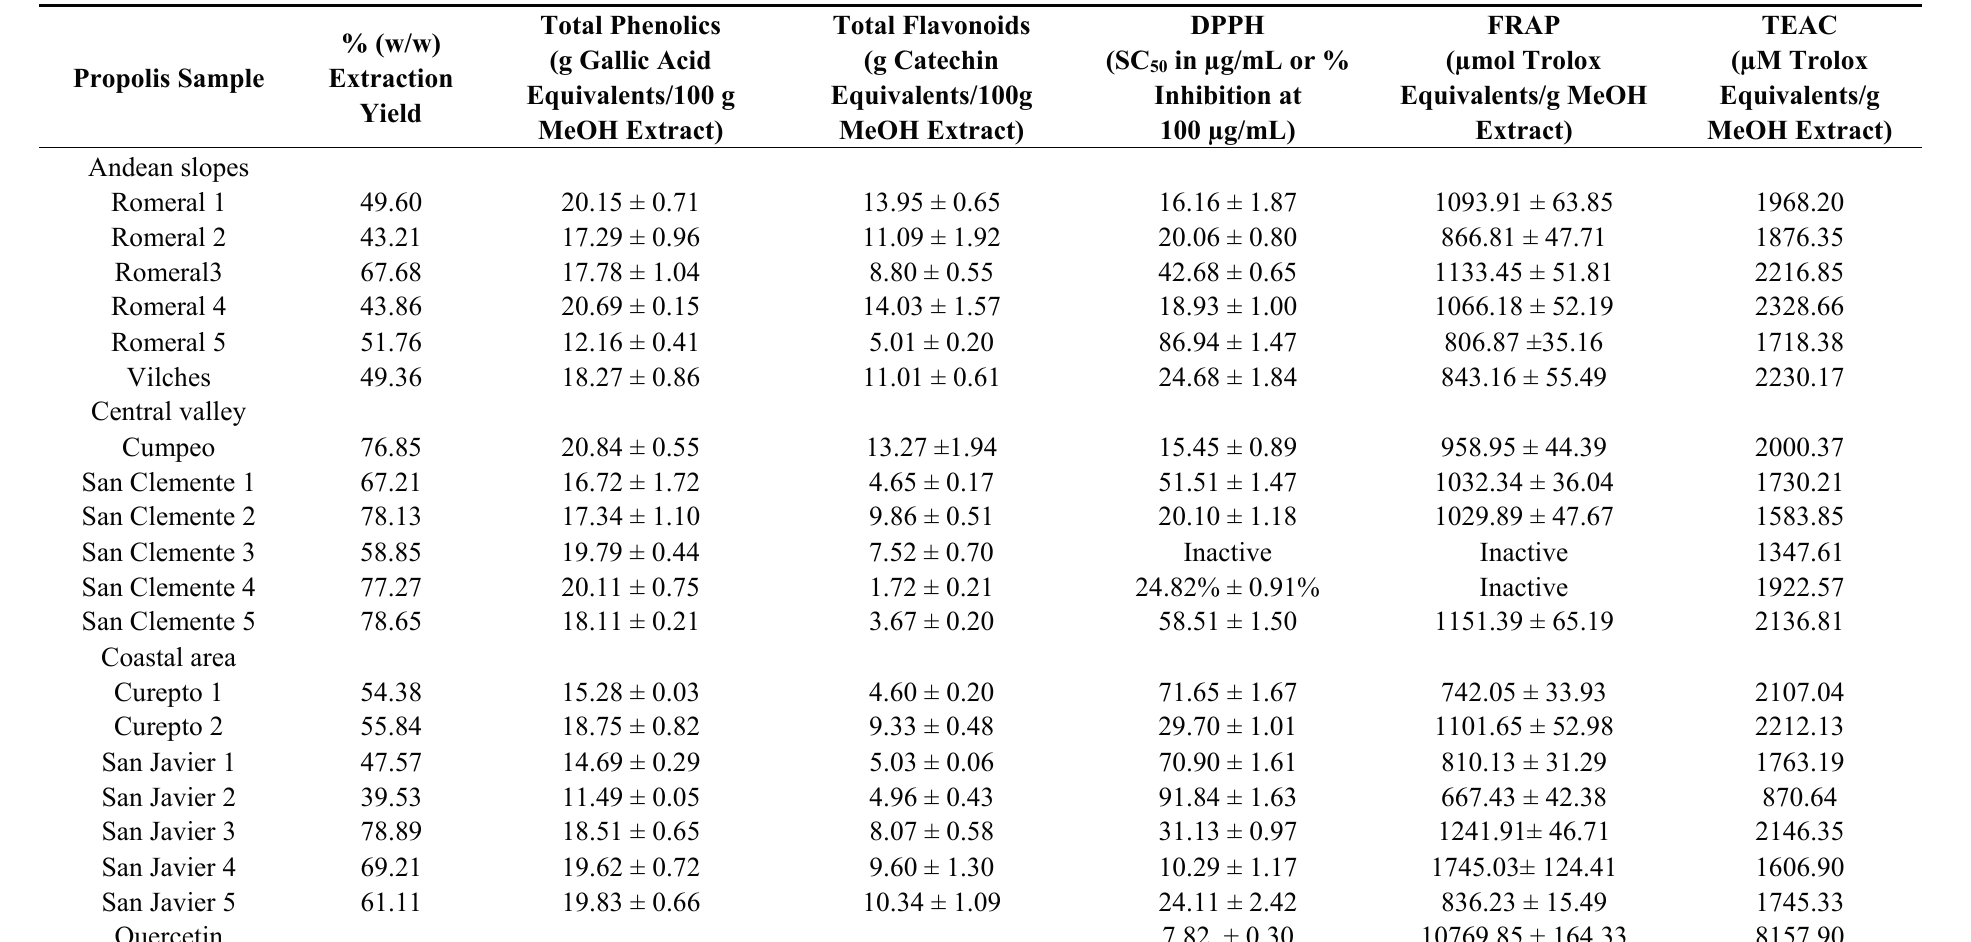
Table 2. Extraction yields, total phenolics (TP), total flavonoids (TF) and antioxidant activity of methanol extract of propolis from the Andean slopes (“precordillera”), central valley and coastal area (“secano costero”), Región del Maule, Chile.